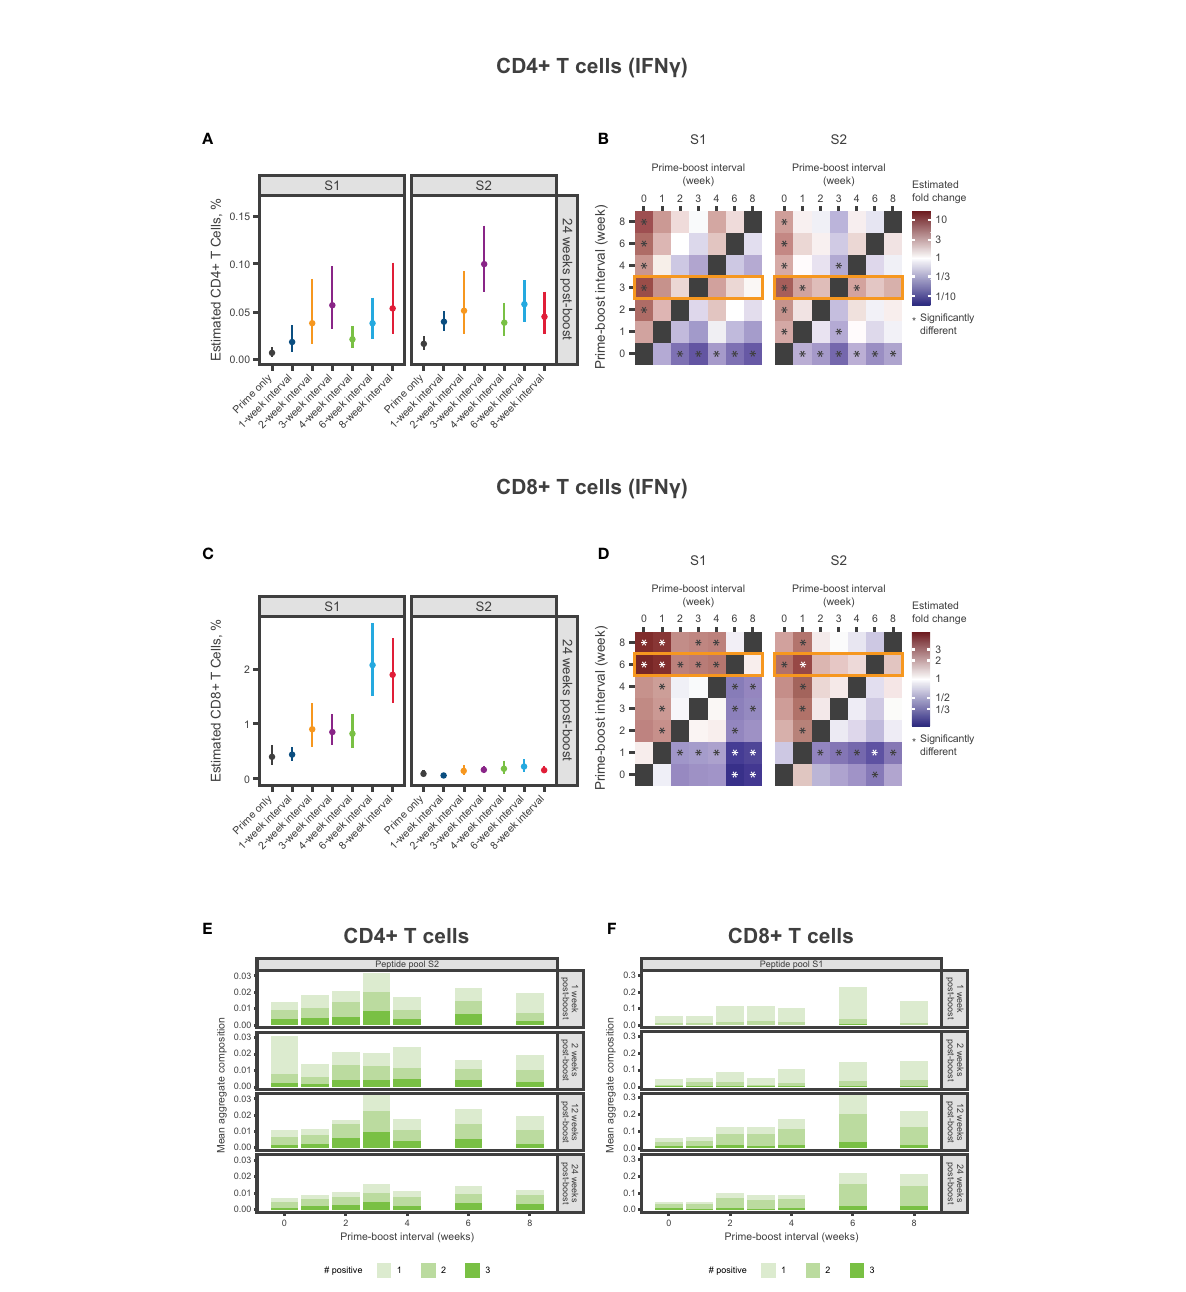
FIGURE 5 Spike-speci fi c CD4+ and CD8+ T-Cell Responses. (A-D) Percentage of SARS-CoV-2 spike-speci fi c IFN g -producing (A) CD4+ T cells or (C) CD8 + T cells at 24 weeks after dose 2 according to antigen (S1 and S2) and mRNA-1273 dosing interval (prime only or 1-, 2-, 3-, 4-, 6-, or 8-week intervals). Panels (A, C) present the estimated mean and associated 95% CIs based on a statistical model (see Methods), with error bars representing the 95% CIs of estimated means. Panels (B, C) present the same results in heatmaps showing fold change between percentages of spike-speci fi c IFN g -producing (B) CD4+ T cells or (D) CD8+ T cells at 24 weeks after dose 2. Signi fi cant differences denoted by an asterisk if the P -value was less than 0.05. Results of statistical comparisons between groups are presented in Table S5, Table S7, Figure S7, and Figure S10. (E, F) Mean aggregate composition of CD4+ T-cell IFN g response to the S2 peptide pool or CD8+ T-cell IFN g response to the S1 peptide pool are presented by mRNA-1273 dosing interval at 1, 2, 12, and 24 weeks following dose 2. Data are presented as averages of individual mice (n=8- 10) within each dosing interval group and time point. These compositions were obtained from a thresholding modeling that accounted for day- and cell type – speci fi c differences (see Methods and Supplementary Methods). Results of statistical comparisons between groups based on a zero-in fl ated beta regression model (see Methods) and shown in Table S6, Figure S9, and Figure S11. Individual animal-level data are presented in Figure S8. CI, con fi dence interval; IFN g , interferon g ; mRNA, messenger RNA; S1, subunit 1; S2, subunit 2; SARS-CoV-2, severe acute respiratory syndrome coronavirus